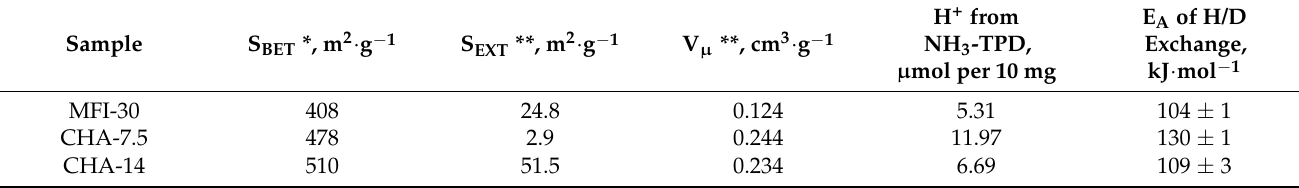
Table 1. Results of characterization